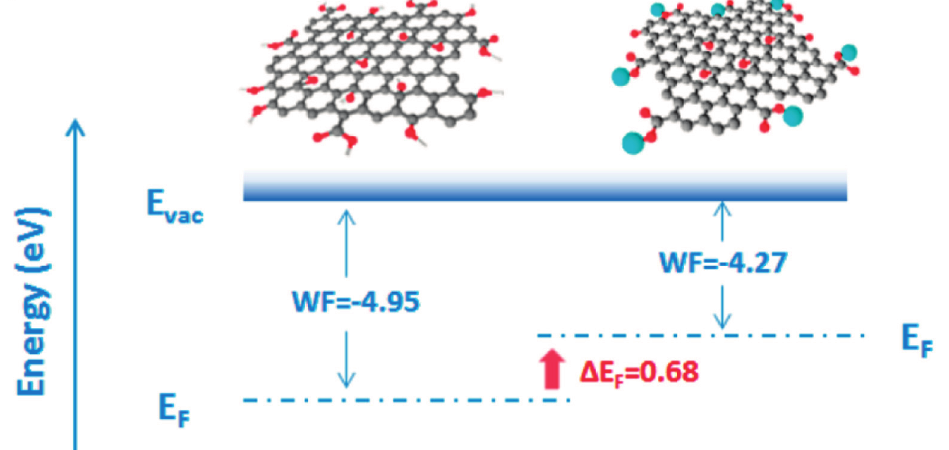
Figure 15. Energy diagram showing the Fermi level of pristine graphene oxide (GO; left ) and lithium-neutralized graphene oxide (GO–Li; right ). Reprinted with permission from [98]. Copyright 2014 American Chemical